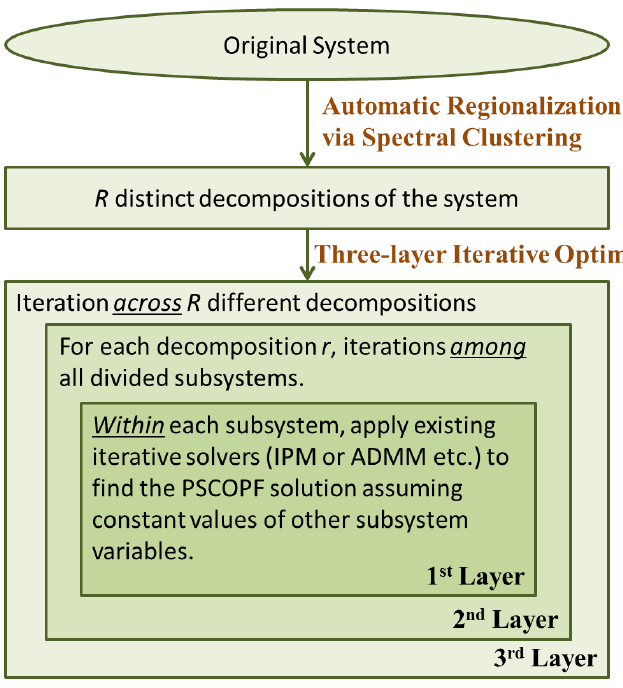
Figure 1. Decomposed iterative optimal power flow (OPF) with automatic